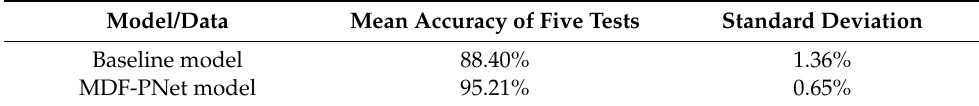
Table 3. Comparison of mean accuracy and standard deviation of the five